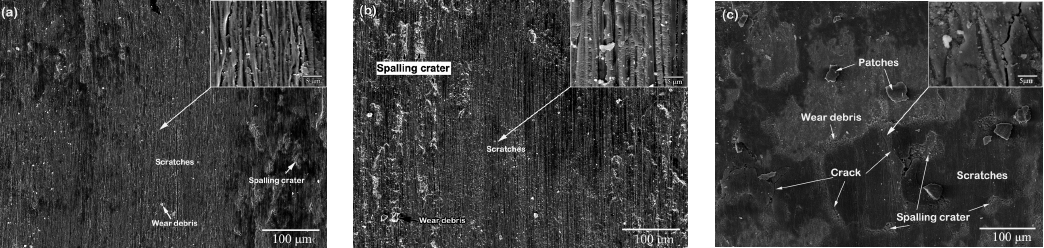
Figure 11. SEM micrographs of the worn surfaces of: ( a ) five-layer LFR; ( b ) 20-layer LFR; and ( c ) substrate.